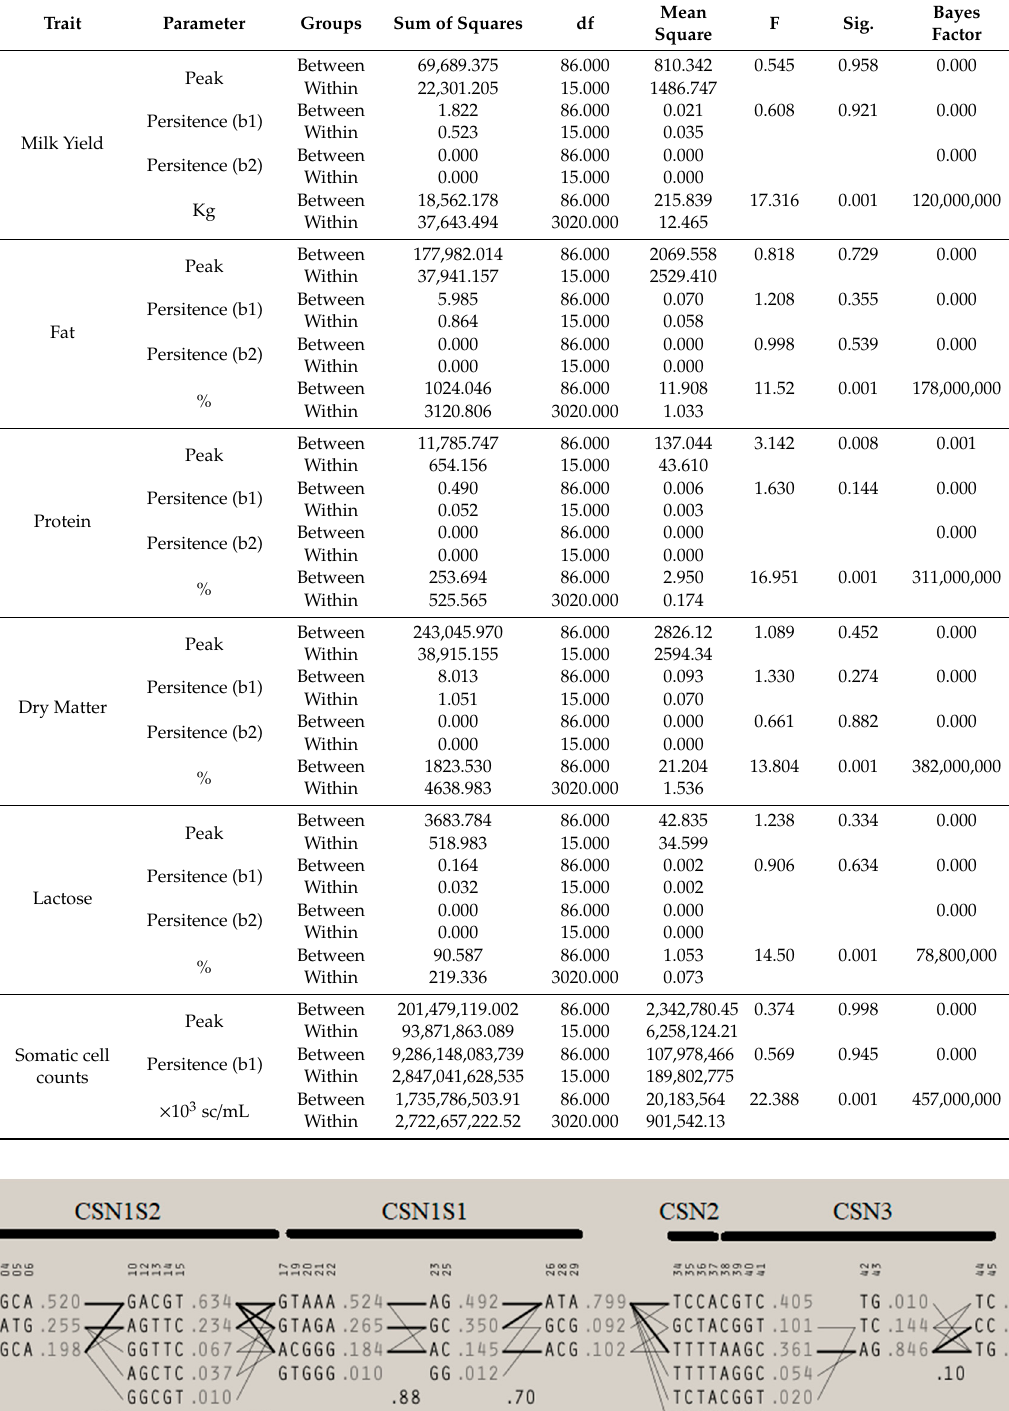
Table 2. Bayesian inference for one-way ANOVA to determine the di ff erences in the mean for milk yield and components and curve parameters through best fitting models across casein haplotypes in Murciano-Granadina goats.